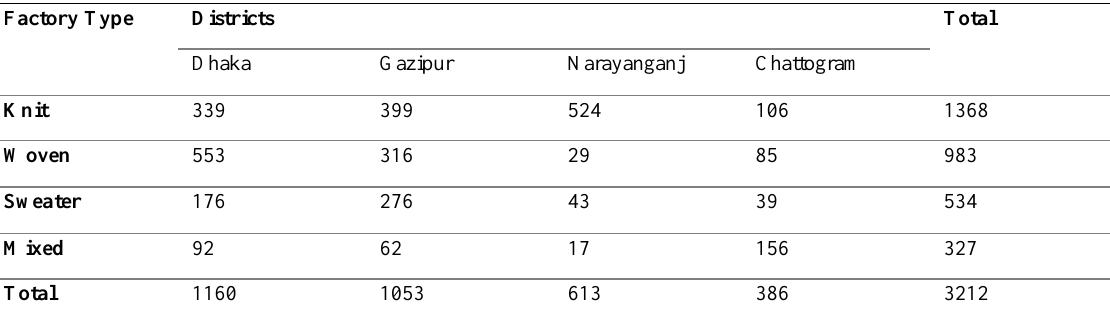
Table 5: Factory Type by